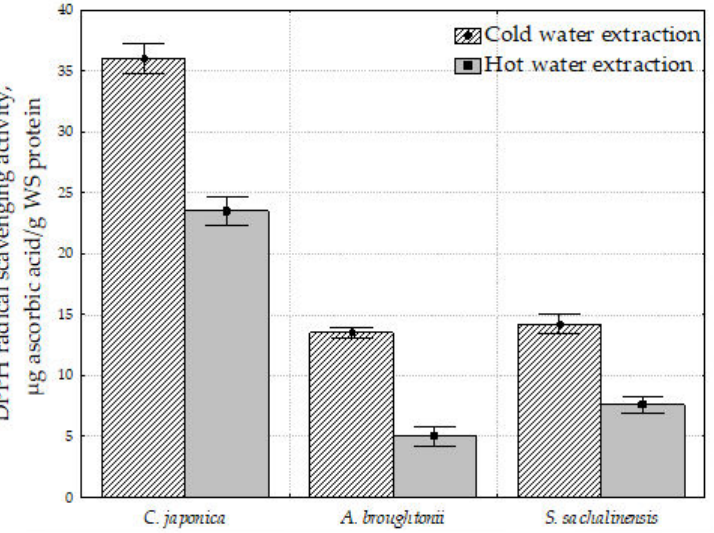
Figure 1. DPPH radical scavenging activity of water-soluble proteins of bivalve tissue. A negative correlation between the DPPH radical scavenging activity and the total amount of tissue proteins was found. The highest radical scavenging activity (36.0 µ g ascorbic acid/g WS protein) of C. japonica tissue had a lower proportion of the total